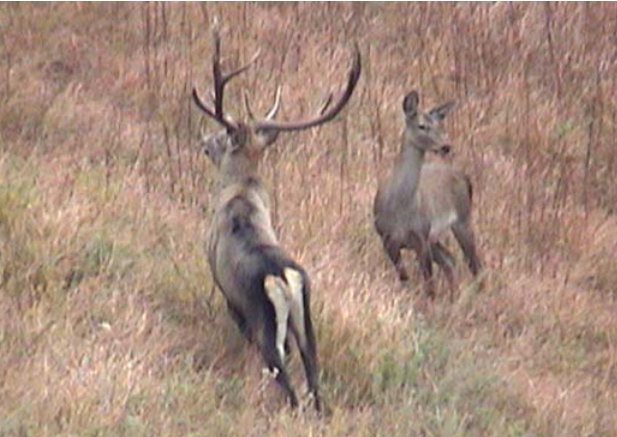
Image 1. Breeding